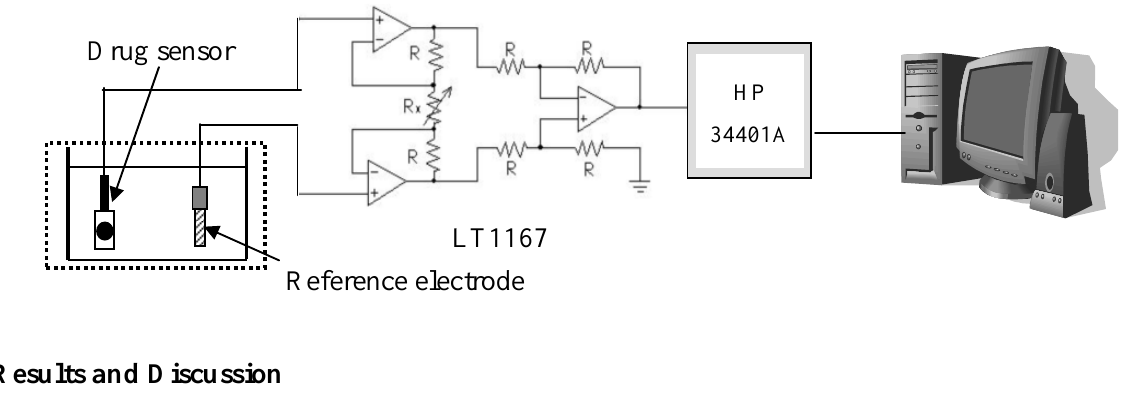
Figure 2 . Voltage-time measurement system used for drug